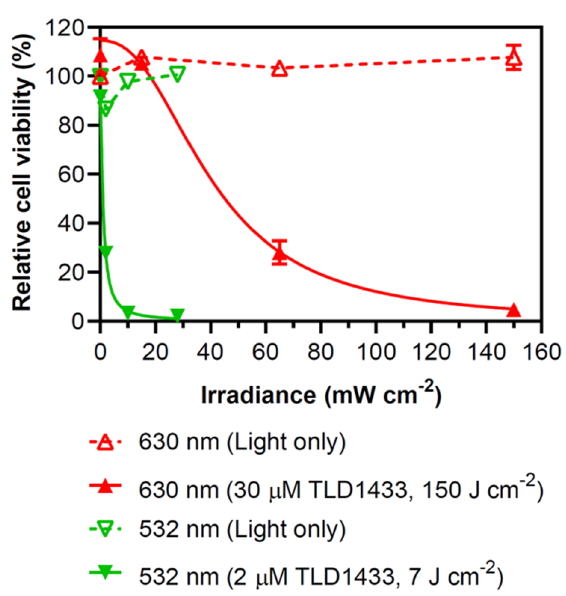
Figure 2. Relative cell viability of A549 cells treated with 630-nm (150 J / cm 2 ) or 532-nm (7 J / cm 2 ) laser light with and without TLD1433. Cell viability was evaluated with rezasurin cell assay. In vitro experiments were completed in triplicate.